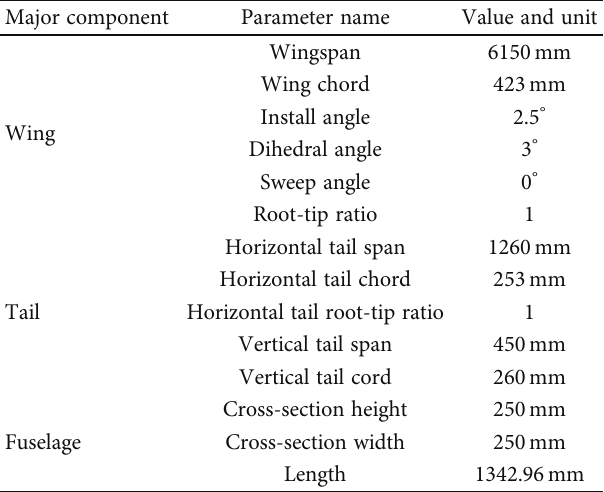
Figure 1: Mission pro fi le and con fi guration of Dandelion I. Table 1: Aerodynamic shape parameters of Dandelion